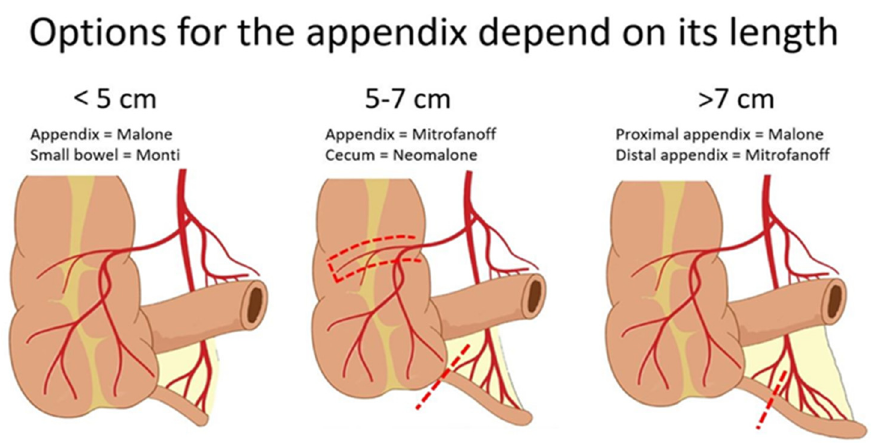
Figure 1. Decision-making in terms of access for antegrade flushes and urinary diversion. If the appendix is shorter than 5 cm, a Malone is created, and urinary access is ensured by creating a Monti channel. If the appendix is 5–7 cm long, it is used for a Mitrofanoff, and a Neomalone